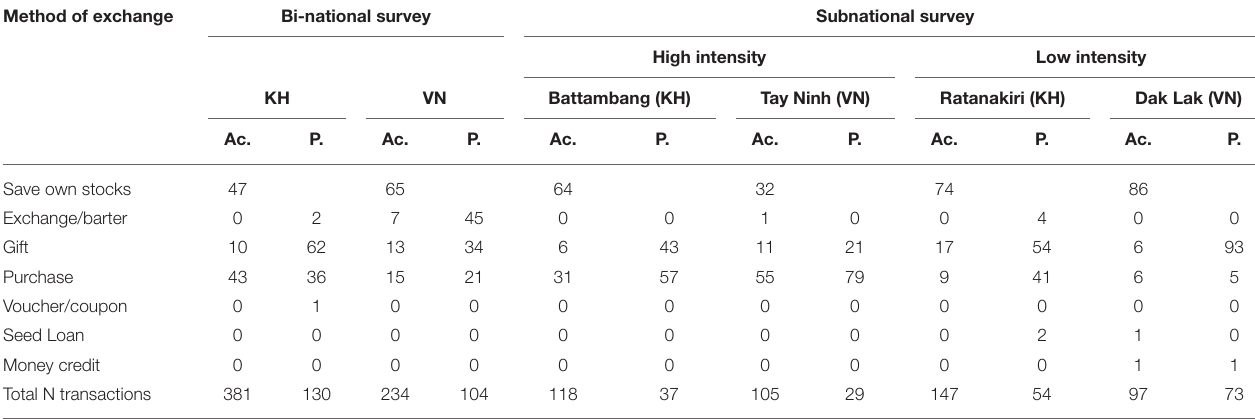
TABLE 5 | Methods of seed exchange reported at one high and one low cassava production intensity site each in Cambodia (KH) and Vietnam (VN) in 2016, presented as percentages of total exchanges at each site. Method of exchange Bi-national